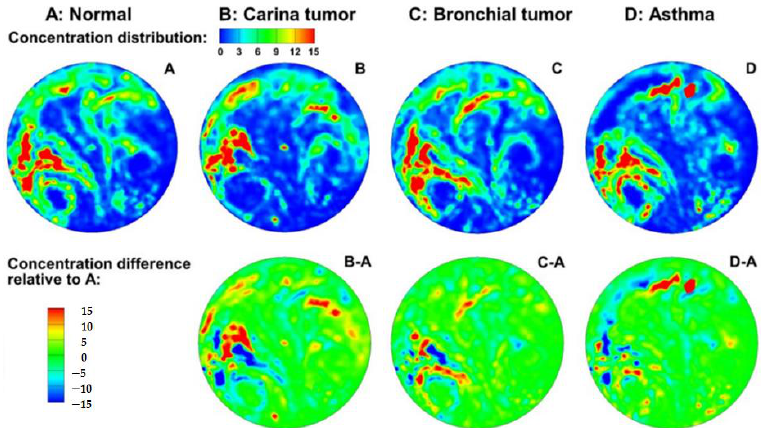
Figure 5. Relative concentrations of exhaled aerosols from the normal and three diseased airway models. The concentration difference in the second row was calculated by subtracting the relative concentration of each model by that of Model A. Adapted from [65].